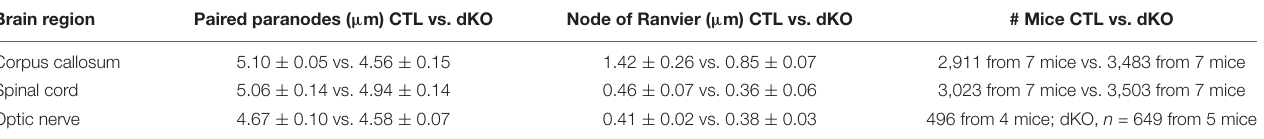
TABLE 1 | The length of paired paranodes in the white matter. Brain region Paired paranodes ( µ m) CTL vs. dKO Node of Ranvier ( µ m) CTL vs. dKO # Mice CTL vs.